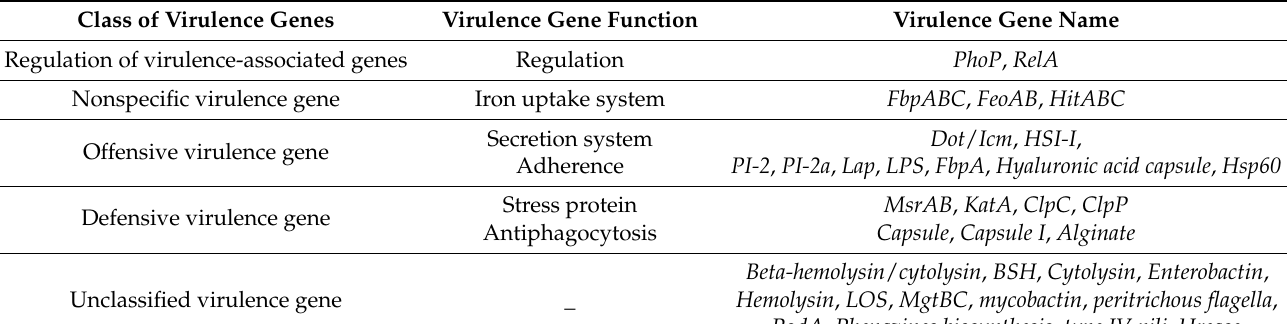
Table 1. Virulence genes identified in Blautia producta DSM 2950.